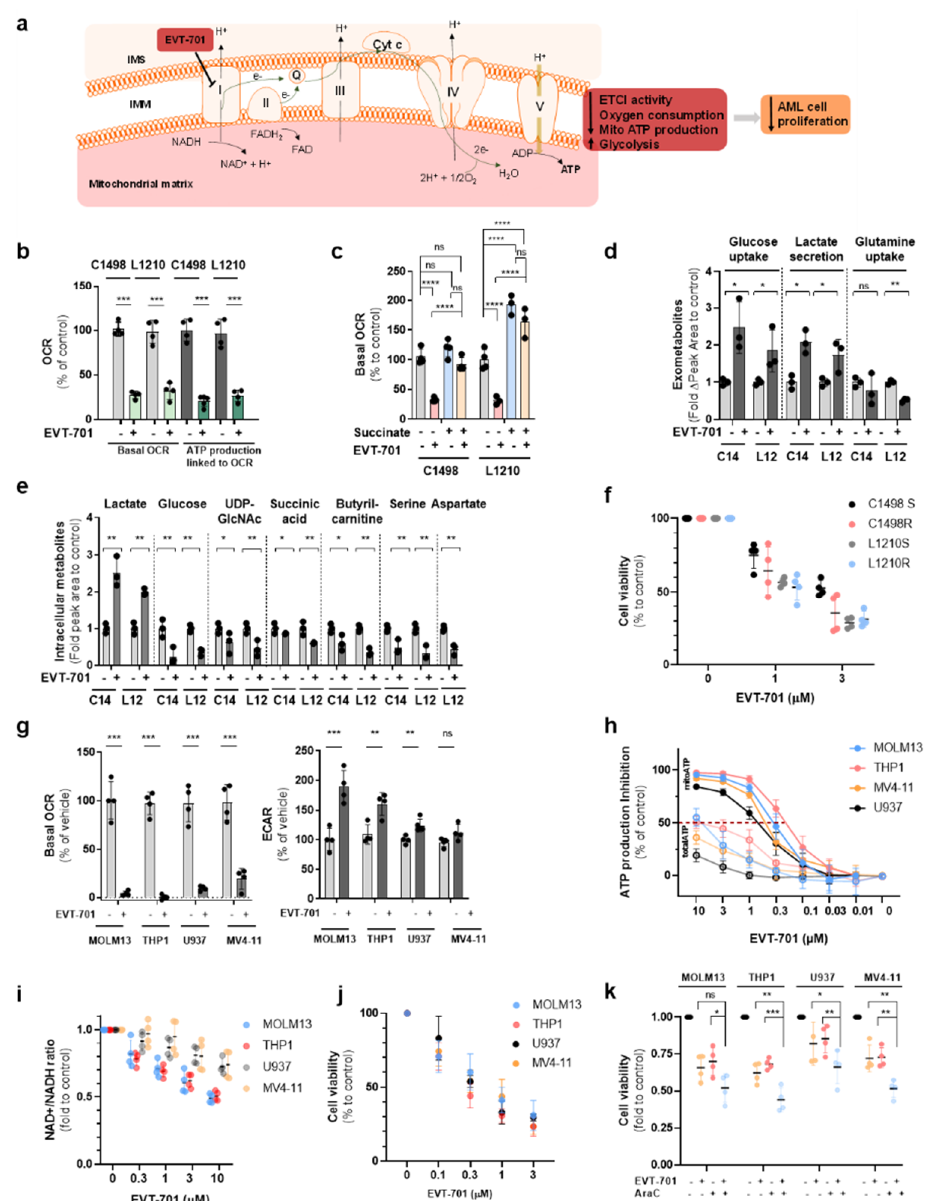
Figure 3. EVT-701 blocks OxPHOS by inhibiting ETCI and induces a profound metabolic compensatory reprogramming. ( a ) Schematic representation of the mode of action of EVT-701. ( b ) Effect of EVT-701 on the basal oxygen consumption rate and ATP production linked to OCR in murine AML cells, assessed by Seahorse ( n = 4). ( c ) Effect of 10 mM succinate supplementation upon ETCI inhibition with EVT-701 in permeabilized leukemic cells ( n = 4 C1498, n = 3 L1201). ( d ) Effect of EVT-701 on lactate and glucose in the exometabolome of C1498 and L1210 after 24 h incubation ( n = 3). ( e ) Effect of EVT-701 on intracellular metabolites in C1498 and L1210 cells after 24 h incubation ( n = 3). ( f ) Effect of EVT-701 on C1498 and L1210 proliferation ( n = 4). ( g ) Effect of EVT-701 on oxygen consumption rate and extracellular acidification rate in human AML cell lines assessed by Seahorse ( n = 4). ( h ) Dose-response effect of EVT-701 on total ATP and mitochondrial ATP production in human AML cell lines assessed by Cell Titer Glo ( n = 4). ( i ) NAD+/NADH ratio change in response to EVT-701 in human AML cell lines ( n = 4). ( j ) Dose-response effect of EVT-701 on human AML cell line proliferation ( n = 4). ( k ) Effect of EVT-701, AraC or their combination on human AML cell line proliferation ( n = 4). * is p < 0.05, ** is p < 0.01, *** is p < 0.005, **** is p < 0.001, ns is statistically non- significant.